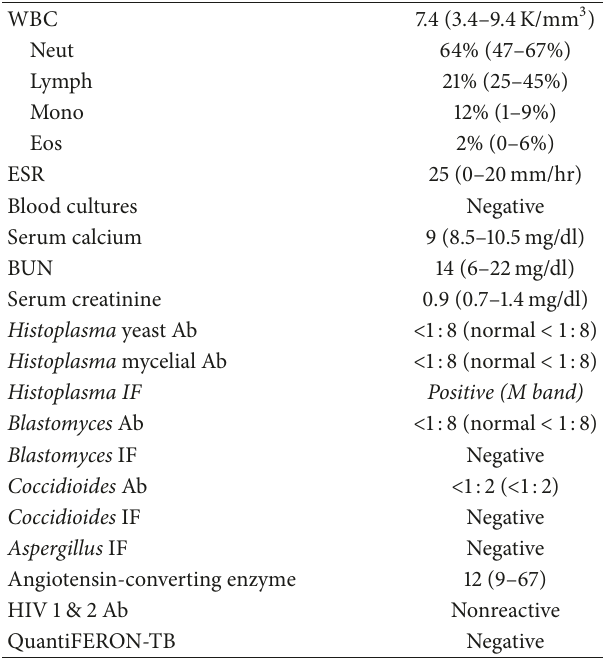
Table 1: Laboratory evaluation and serologic